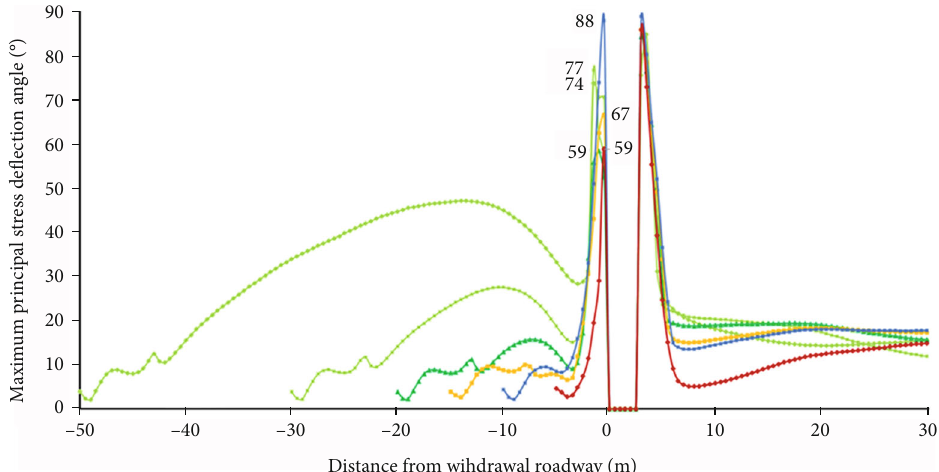
Figure 10: Variation trend of the principal stress angle of coal pillars on both sides of the withdrawal channel during fi nal mining.